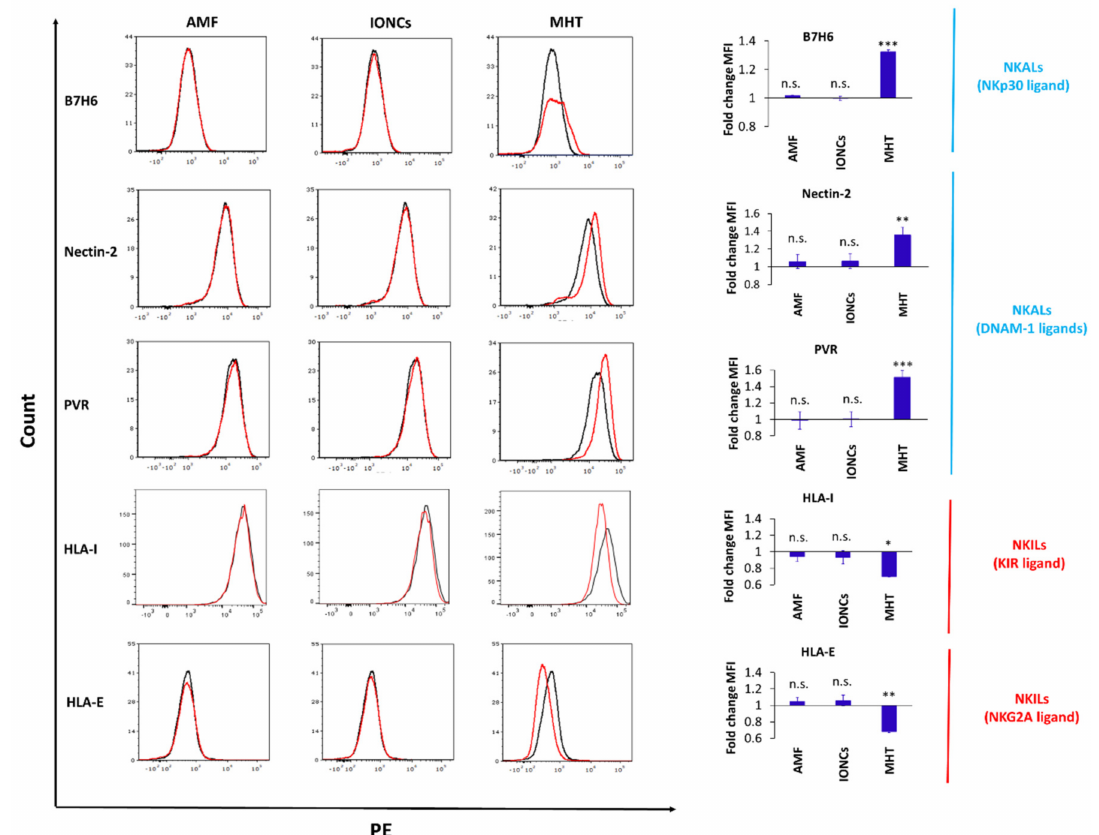
Figure 6. Flow cytometric evaluation of changes in surface expression of NK ligands (Nectin − 2, PVR, HLA − I and HLA − E) with NK activating (NKALs) or inhibitory (NKILs) functions in U87 cells exposed to different treatments including AMF only (AMF), IONCs only (IONCs) and IONCs + AMF (MHT) compared to untreated cells at 24 h post − treatment. Data are shown as representative histograms and expressed as average fold change (mean ± SD) of the mean fluorescence intensity (MFI) of three independent experiments ( n = 3). Statistical analysis was conducted via two − tailed unpaired student’s t test (* 0.01 < p < 0.05; ** 0.001 < p < 0.01; *** p < 0.001; n.s. = not